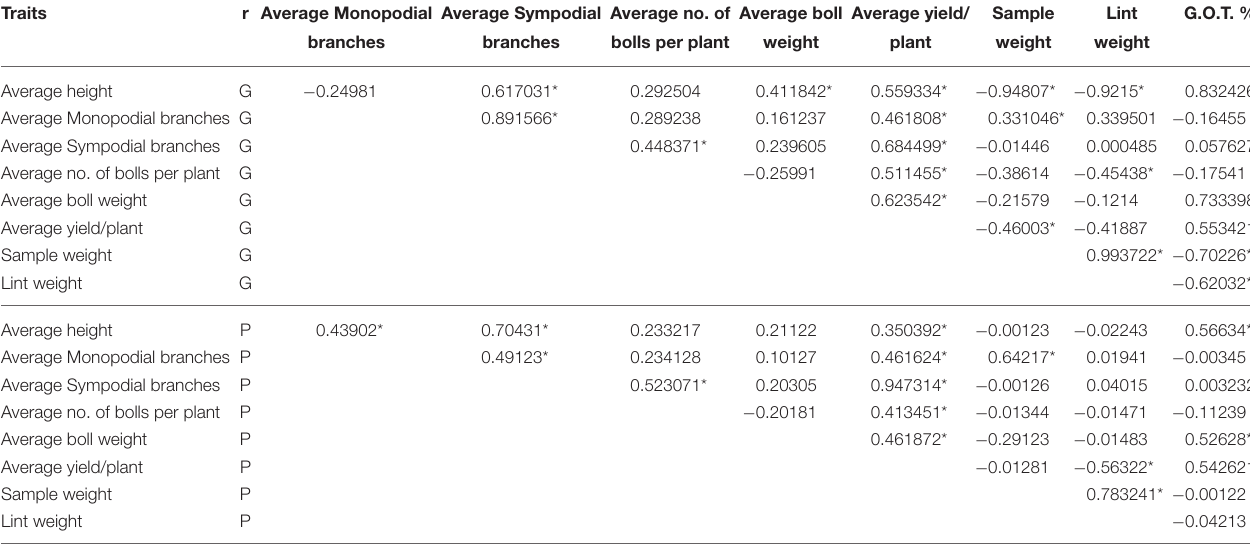
TABLE 3 | Genotypic (G) and Phenotypic (P) correlation matrix for yield traits of transgenic cotton.